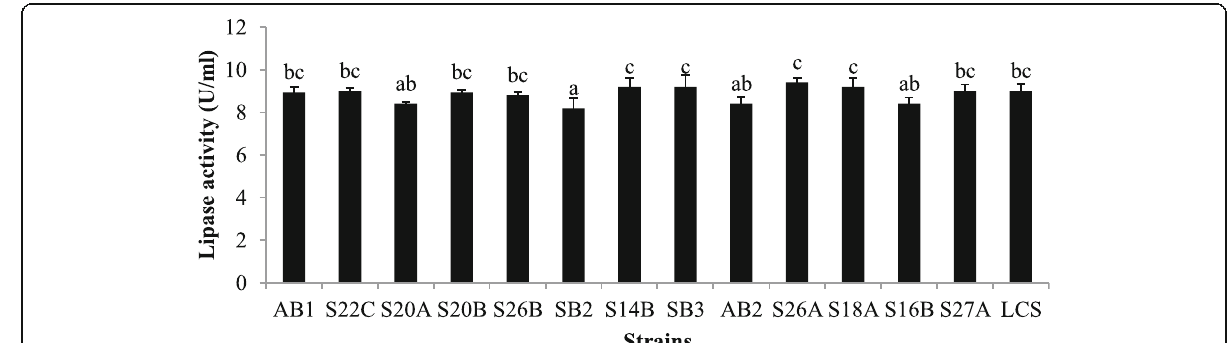
Fig. 1 Lipase activity of the Enterococcus strains. The strains are AB1; E. canintestini AB1, S22C; E. rivorum S22C, S20A; E. phoeniculicola S20A, S20B; E. dispar S20B, S26B; E. canintestini S26B, SB2; E. villorum SB2, S14B; E. rivorum S14B, SB3; E. canintestini SB3, AB2; E. canintestini AB2, S26A; E. dispar S26A, S18A; E. canintestini S18A, S16B; E. dispar S16B, S27A; E. dispar S27A, LCS; and L. casei Shirota, respectively. Columns with different letters are significantly different p < 0.05